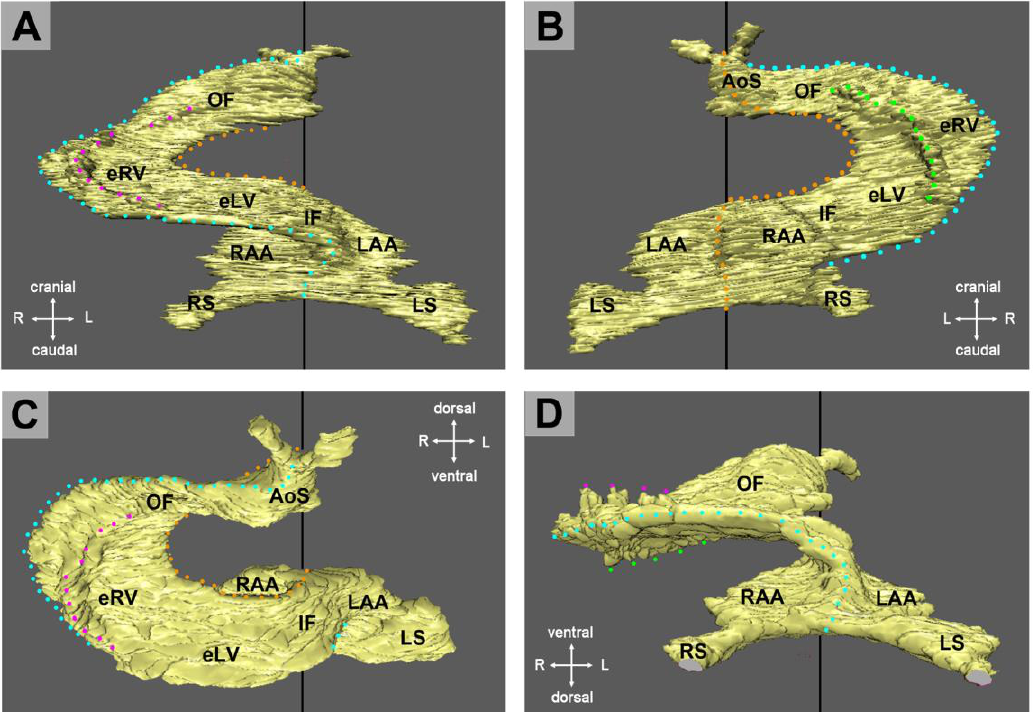
Figure 9. These pictures show the outer shape of an occluded endocardial tube of an embryonic chick heart during the initial phase of ventricular tube remodeling (HH-stage 14). Images were generated by virtual 3-D reconstructions of OCT data sets from a heart that has been fixed in an artificially induced general contraction. ( A ) Frontal view. ( B ) Dorsal view. ( C ) Cranial view. ( D ) Caudal view. The outer curvature of the ventricular bend has a folded surface, which is characterized by three folds: (1) A midline fold that corresponds to the original ventral edge of the occluded endocardial tube (marked by lines of blue dots). This fold subdivides the trabecular shields into two halves. (2, 3) A pair of lateral folds that form the lateral borders of the trabecular shields (marked by dotted lines in magenta and green). Abbreviations: eLV = embryonic left ventricle; eRV = embryonic right ventricle; IF = inflow portion of ventricular tube; RAA = anlage of right atrial appendage; RS = right horn of sinus venosus; LS = left horn of sinus venosus; OF = outflow portion of ventricular tube.